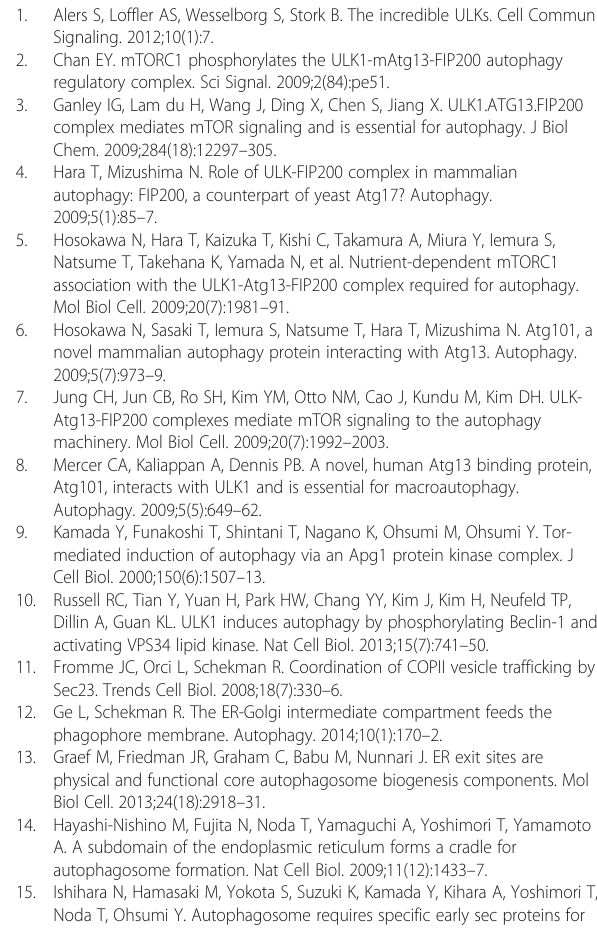
Additional file 5: Figure S5. Sec23A mutants in COS cells. The indicated Myc-His-Sec23A mutants were transfected into COS cells before fixation and staining with anti-c-Myc antibody. (TIFF 3776 kb) Additional file 6: Figure S6. The interactions between the ULK1 phosphorylation mutants of Sec23A and Sec31A. (A) S207 and T405 mutants of Sec23A were tested for their interaction with Sec31A by co- expressing the Myc-His-Sec23A mutants and GFP-Sec31A. (B) Combinations of S207 and T405 double mutants were tested for the interaction with Sec31A. Overexpression of the indicated protein was carried in HEK293T cells, followed by immunoprecipitation of Myc-His-Sec23A by anti-Myc antibody. Co-precipitated GFP-Sec31A was detected by anti-GFP antibody. (B) Wildtype Sec23A, S207A and T405A mutants were tested for the interaction with GFP-Sec31A in growth medium or in amino acid starved medium EBSS. (TIFF 5305 kb) Additional file 7: Figure S7. GFP-Sec23B was poorly localized with Sec31A positive ERES. GFP-Sec23B (green) and Sec31A (red) were visualized in Hela cells grown in growth medium or after amino acid starvation for 1 and 2 h. GFP-Sec23B signal were largely ribbon-like structures juxtaposed Sec31A signals. In cells in which GFP-Sec23B signals were punctate, colocalization with Sec31A was still poor (inset). (TIFF 5601